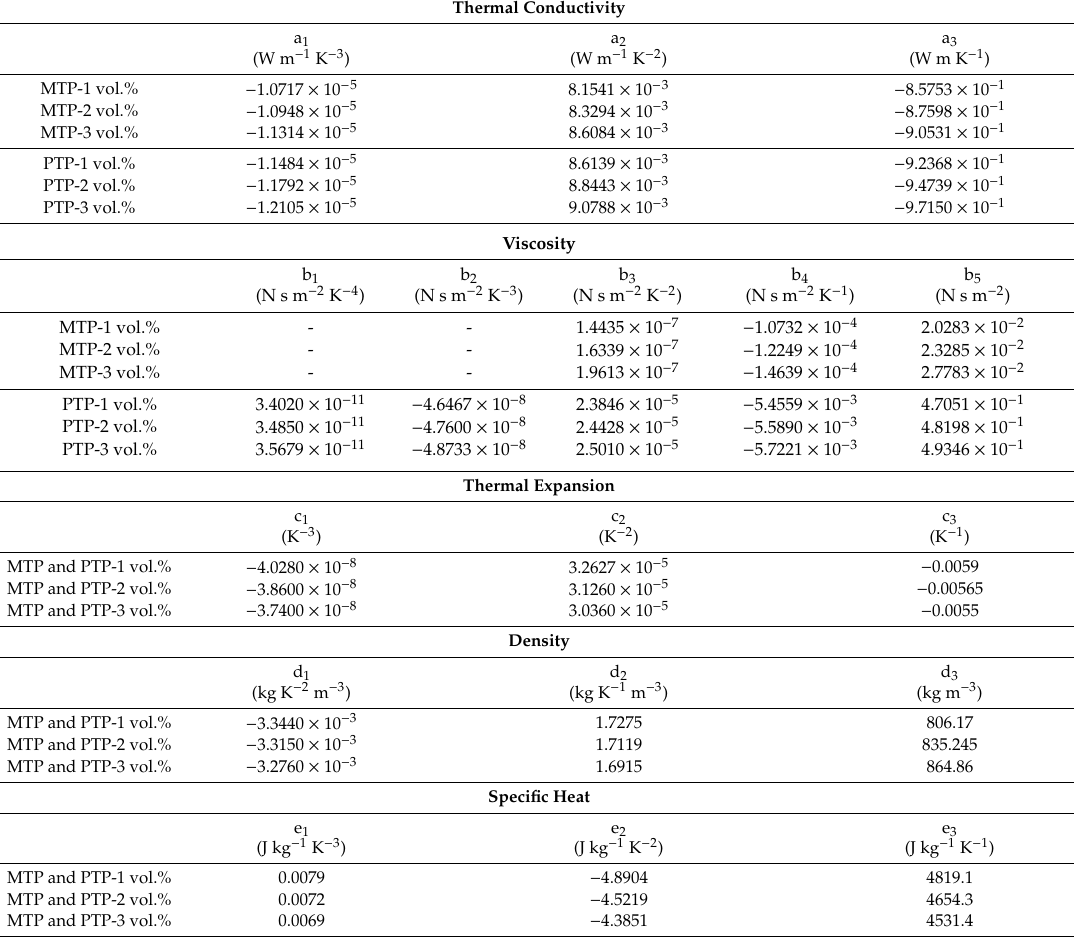
Table A2. Constants in polynomials of thermophysical properties of